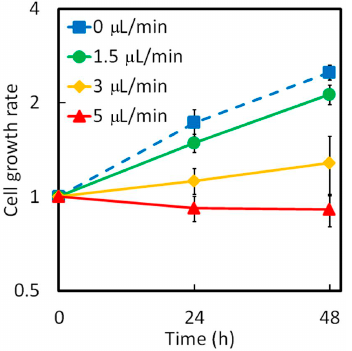
Figure 7. Influence of shear stress in the microchamber on the HeLa cells.